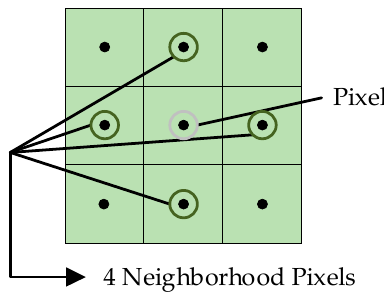
Figure 2. The selection of neighborhood nodes.